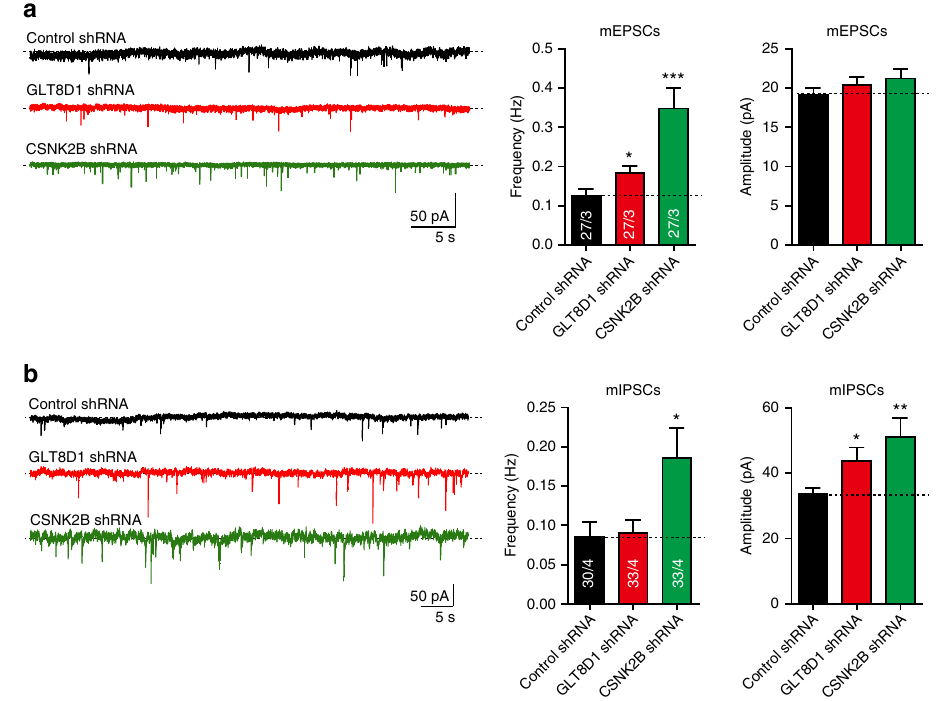
Fig. 6 Knockdown of GLT8D1 and CSNK2B alters synaptic transmission. a Compared with control neurons, knockdown of GLT8D1 and CSNK2B affected the frequency of miniature excitatory postsynaptic currents (mEPSCs) signi fi cantly. However, the amplitude of mEPSCs was not affected. b Compared with controls neurons, the amplitude of miniature inhibitory postsynaptic currents (mIPSC) was signi fi cantly affected in neurons transfected with GLT8D1 and CSNK2B shRNAs. The frequency of mIPSC was also signi fi cantly altered in neurons transfected with CSNK2B shRNAs compared with controls. A total of 27 neurons (from three independent groups) were recorded for mEPSC. For mIPSC, 30 neurons (from four independent groups) were recorded for control group, and 33 neurons (from four independent groups) were recorded for GLT8D1 and CSNK2B knockdown groups. * P < 0.05, ** P < 0.01, *** P < 0.001, Student ’ s t -test. Data represent mean ±